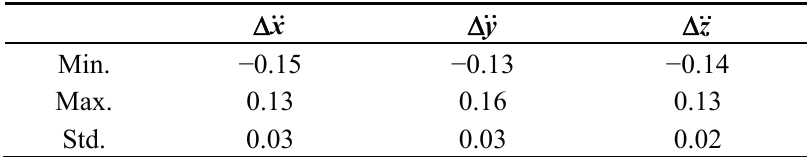
Figure 6. Differences between the estimated kinematic accelerations and reference values. Table 4. Statistical characteristics of the differences between the estimated kinematic accelerations and the reference values (unit: m/s 2